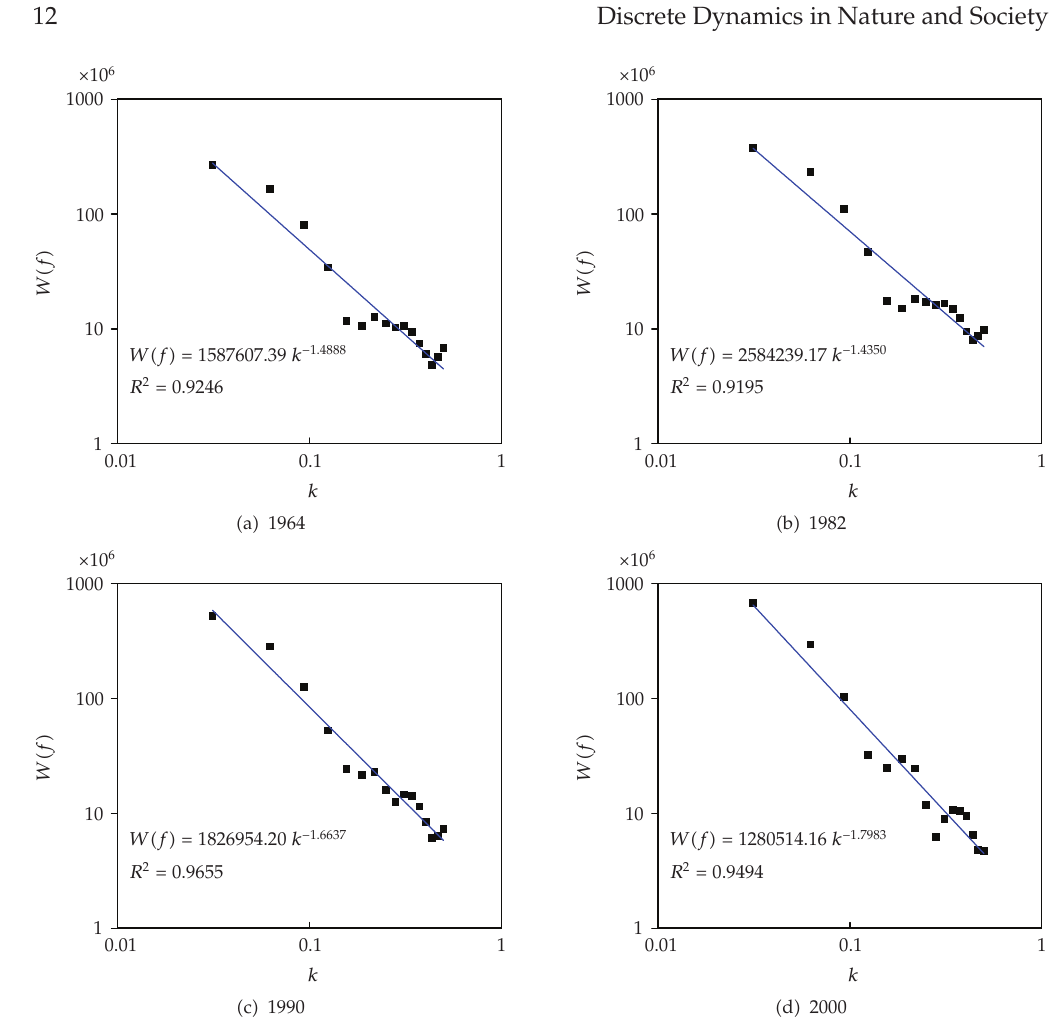
Figure 3: Wave-spectra plots of Hangzhou urban population density distribution: